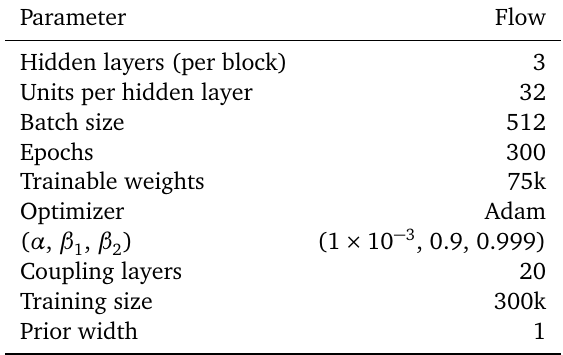
Hyper-parameters for all toy models, implemented in P Y T ORCH (v1.4.0) [ 74 ]